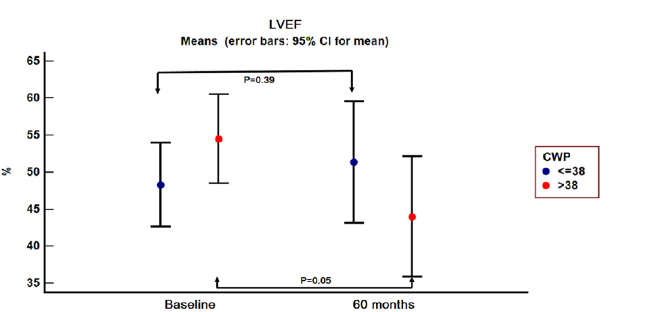
Figure 5. Left ventricular ejection fraction evolution in the two groups from baseline to 60 months follow-up. 95% CI = 95% confidence interval; CWP = coronary wedge pressure; LVEF = left ventricular ejection